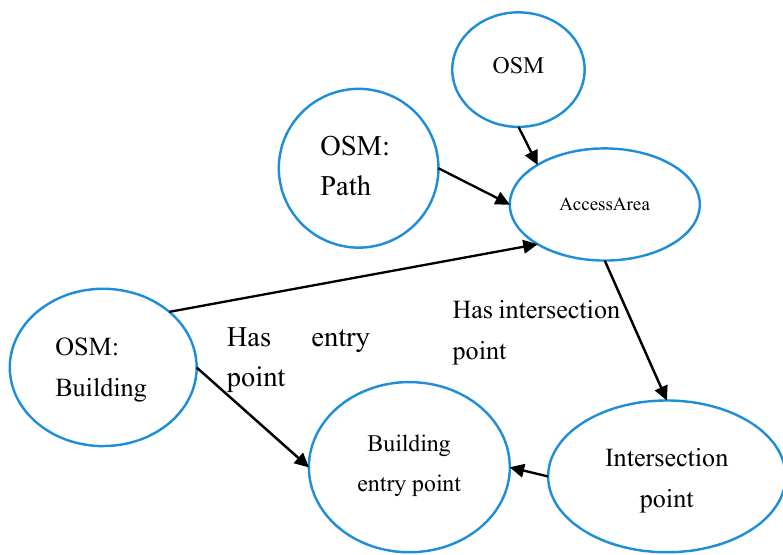
Figure 7. OWL ontology model of spatial relations between buildings and access areas (paths or steps).